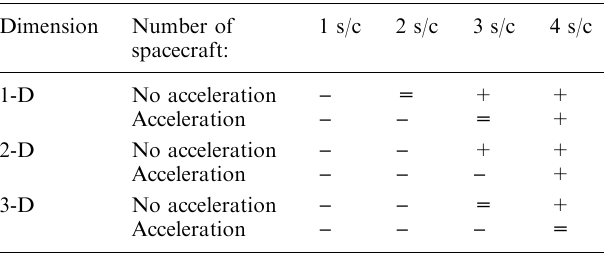
Table 1. Indication of the ability of the analysis to determine the unknowns in di(cid:128)erent physical situations and to lowest order in curvature (taken from Dunlop and Woodward, 1998)